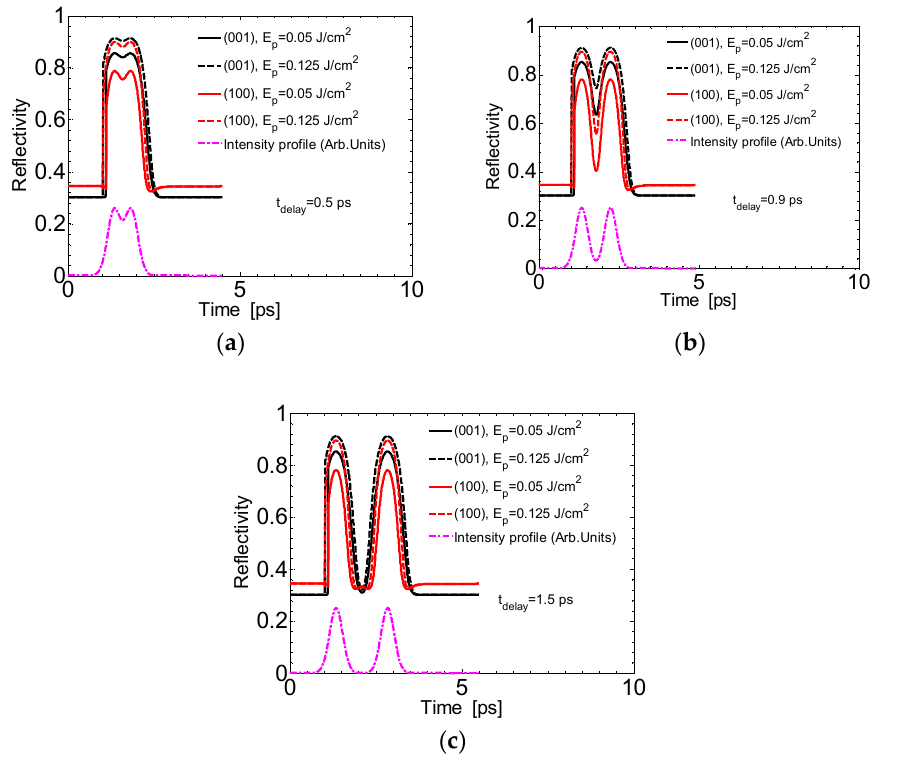
Figure 3. Evolution of carrier densities for E p = 50 mJ/cm 2 and 125 mJ/cm 2 for (001) and (100) crystal orientation at t delay = 0.5 ps ( a ), 0.9 ps ( b ), and 1.5 ps ( c ).